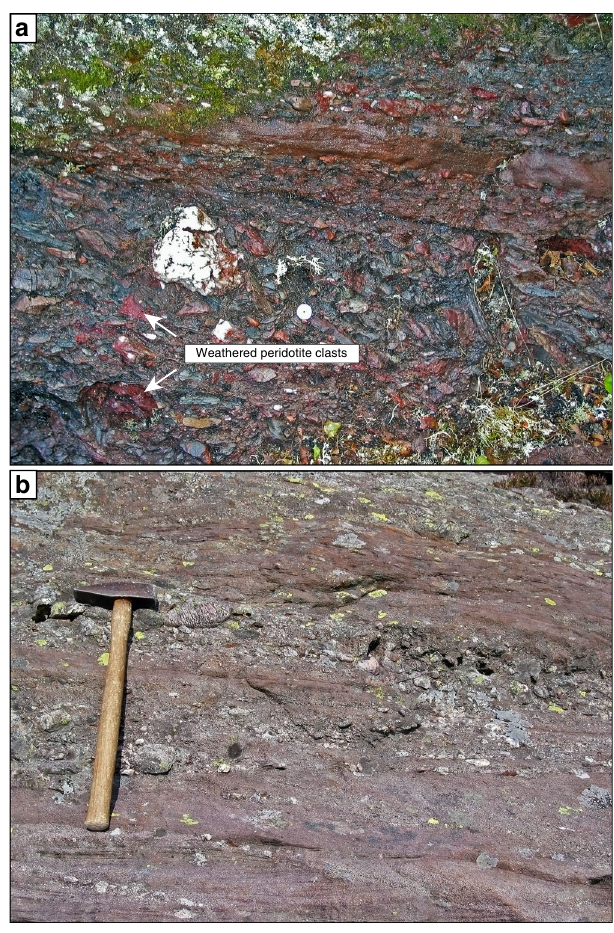
Fig. 8 Outcrop photographs of ultrama fi c detritus-bearing Devonian sediments. a Coarse-grained conglomerate in the Feragen basin containing abundant weathered serpentinized peridotite. Red clasts resembling jasper are weathered peridotite and often contain serpentinite and peridotite in the core. b Sandstone layer in the Solund basin. Sandstone layers from both locations are strongly enriched in Ni and Cr but otherwise consistent with the composition of the continental and andesitic